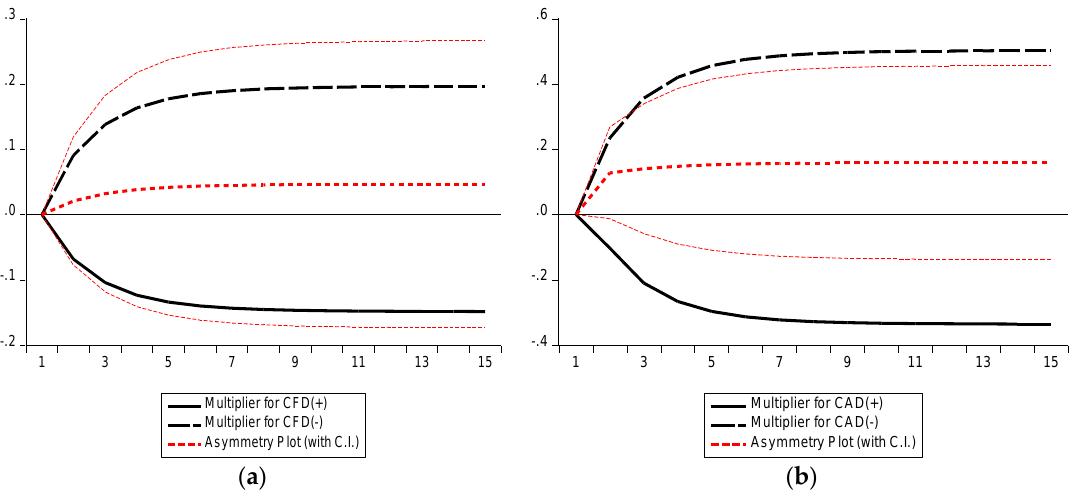
Multiplier for CAD(+) Multiplier for CAD(-) Asymmetry Plot (with C.I.)